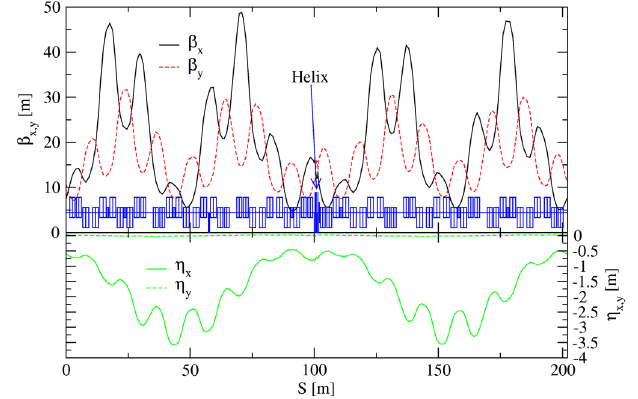
FIG. 8. The beta ( (cid:1) x;y ) and eta ( (cid:2) x;y ) functions over three superperiods of the bare AGS. The horizontal and vertical tune quadrupoles (one horizontal and one vertical in each superper- iod) are set to zero. The corresponding betatron tunes appear in the 2nd row of Table II.